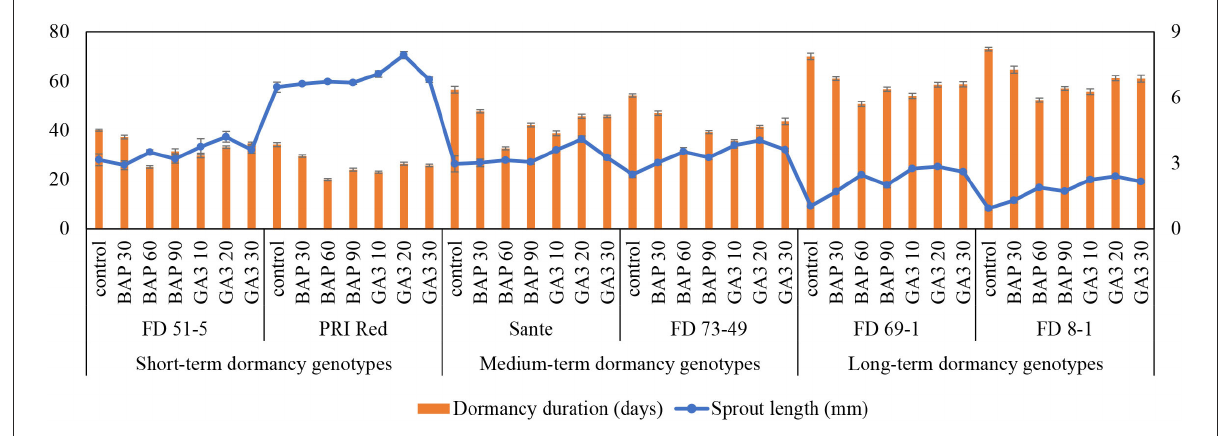
FIGURE1 Mean comparison of dormancy duration (days) and sprout length (mm) in potato tubers under genotype × PGR interactive effect. Vertical error bars represent standard error of